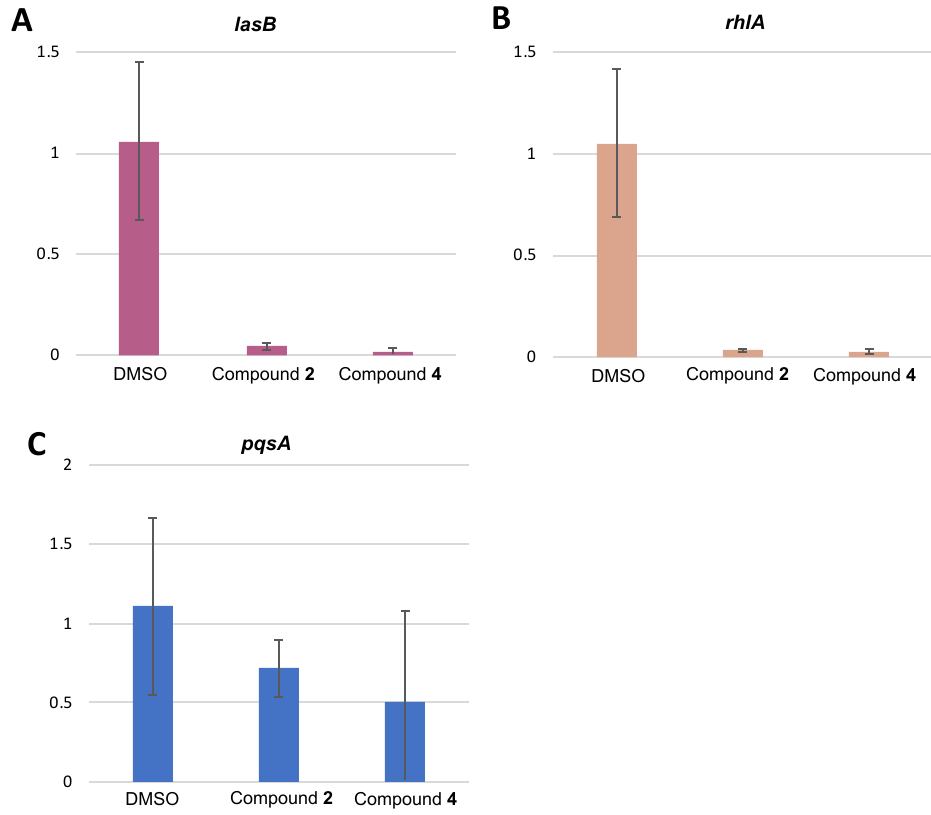
Figure 5. Effect of compounds 2 and 4 on the expression of QS-regulated genes: ( A ) lasB , ( B ) rhlA , ( C ) pqsA. Cultures of PAO1 were grown in triplicates with the compound of interest at 128 µ g/mL for 4 h. DMSO 1.28% was used as solvent control. Error bars indicate standard